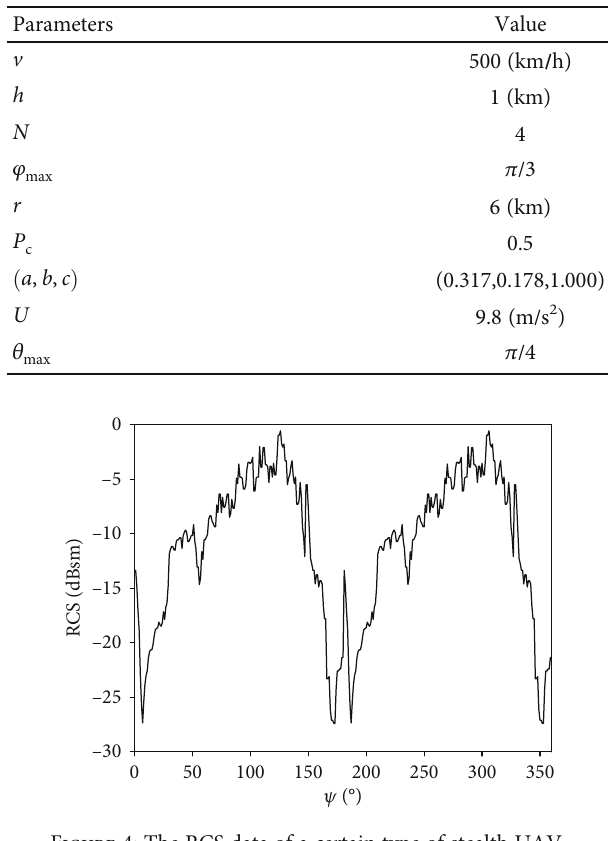
Table 1: Parameters of path planning.